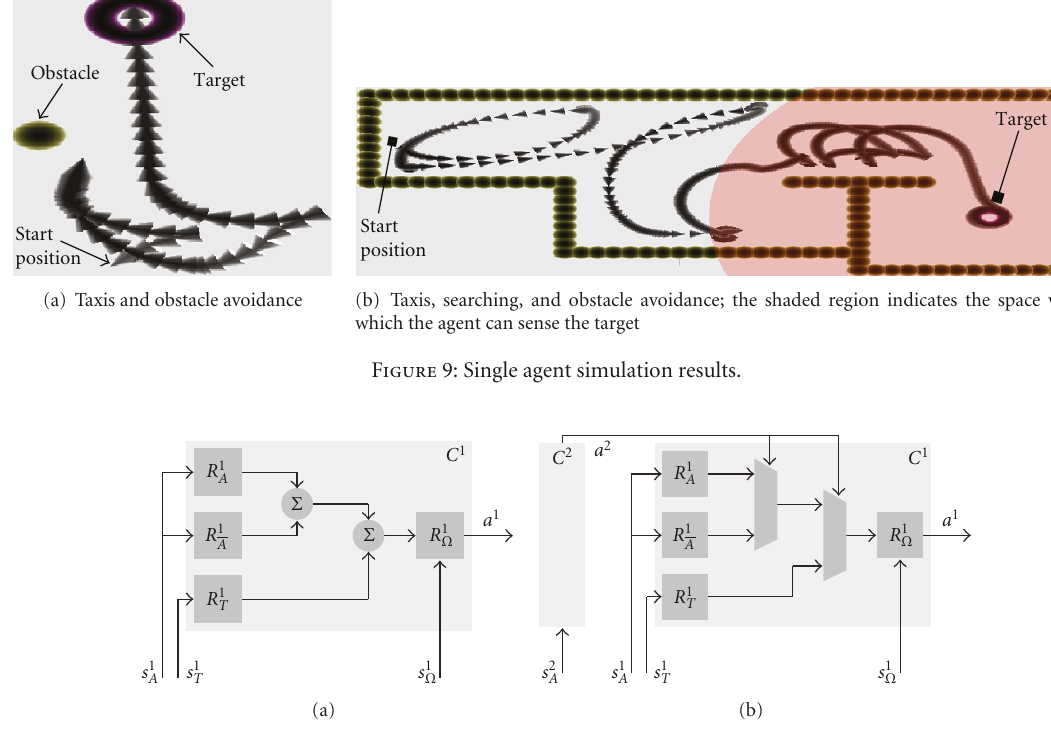
Figure 10: Two action selection schemes for multi-agent behavior; R A and R A are taxis and anti-taxis controllers, respectively, where the sensory feedback comes from other agents, R T is a controller for tracking the common target, T , and R Ω is a system that attenuates translational motion towards